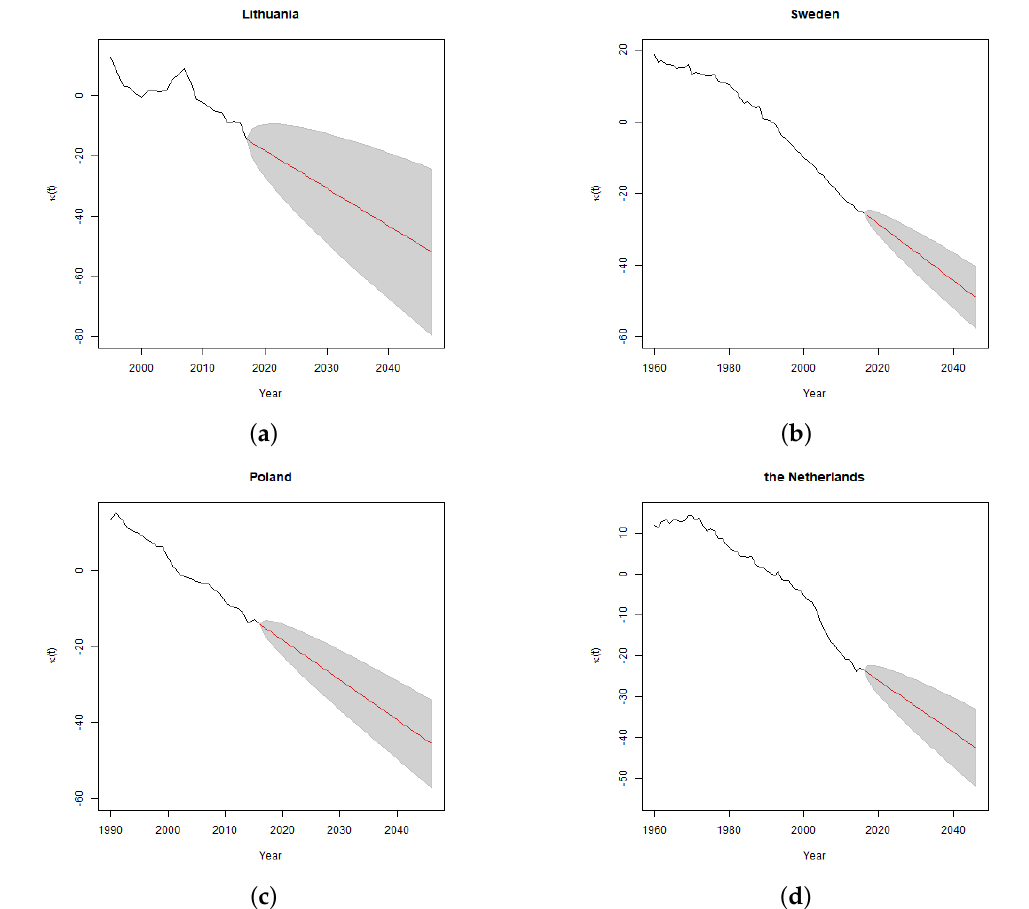
Figure 9. Fitted and forecasted κ ( t ) parameters modelled as RWD using data of Lithuania ( a ), Sweden ( b ), Poland ( c ) and the Netherlands ( d ). The shaded error represents 95% confidence interval of the projections assuming normal distribution of